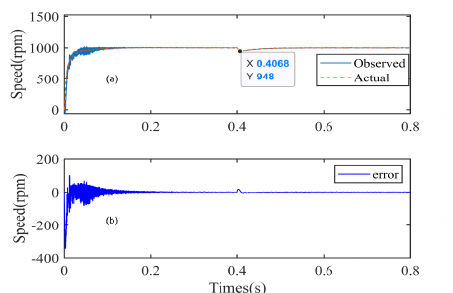
Figure A4. The speed response of VPDPI regulator when J = 0.0006 and R s = 0.011. ( a ) Observed speed and actual speed. ( b ) Estimation error curve